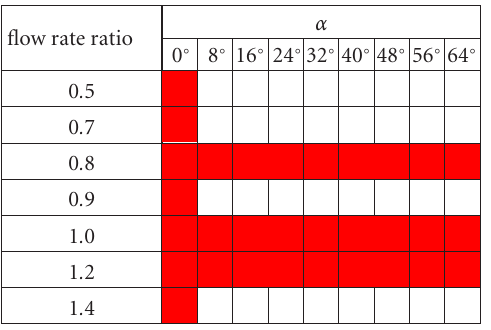
Table 4: Matrix of proposed quasi-unsteady flow simulations.